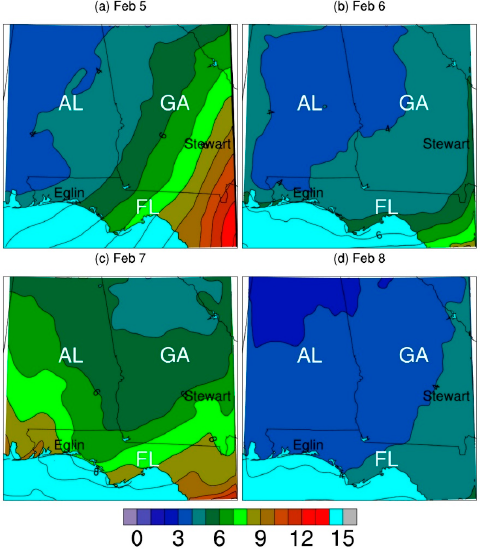
Figure 2. Surface specific humidity (g/kg) simulated with WRF. ( a – d ) are 5–8 February 2011 at noon local time. GA, FL, and AL stand for Georgia, Florida and Alabama. Stewart and Eglin are hypothetical FASMEE burn site and historical burn site, respectively.